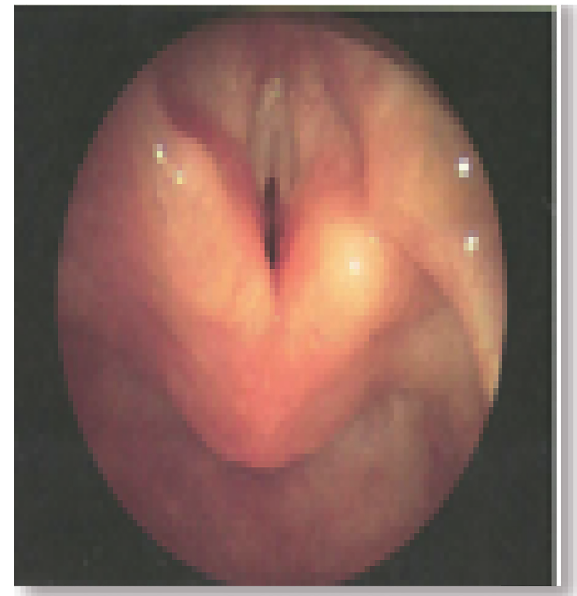
Figure 7: Anterior subglottic